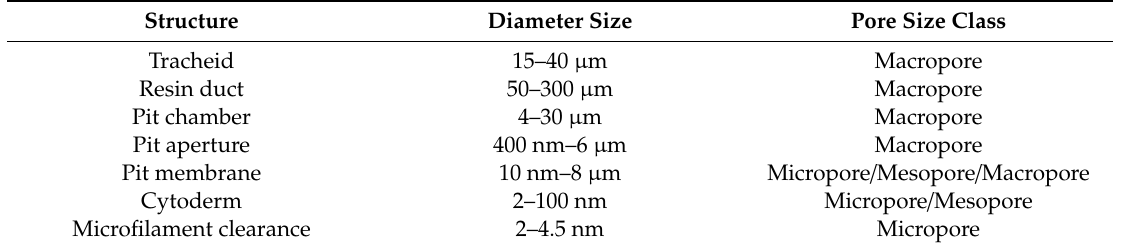
Table 2. Classification of pore structure in Pinus sylvestris .